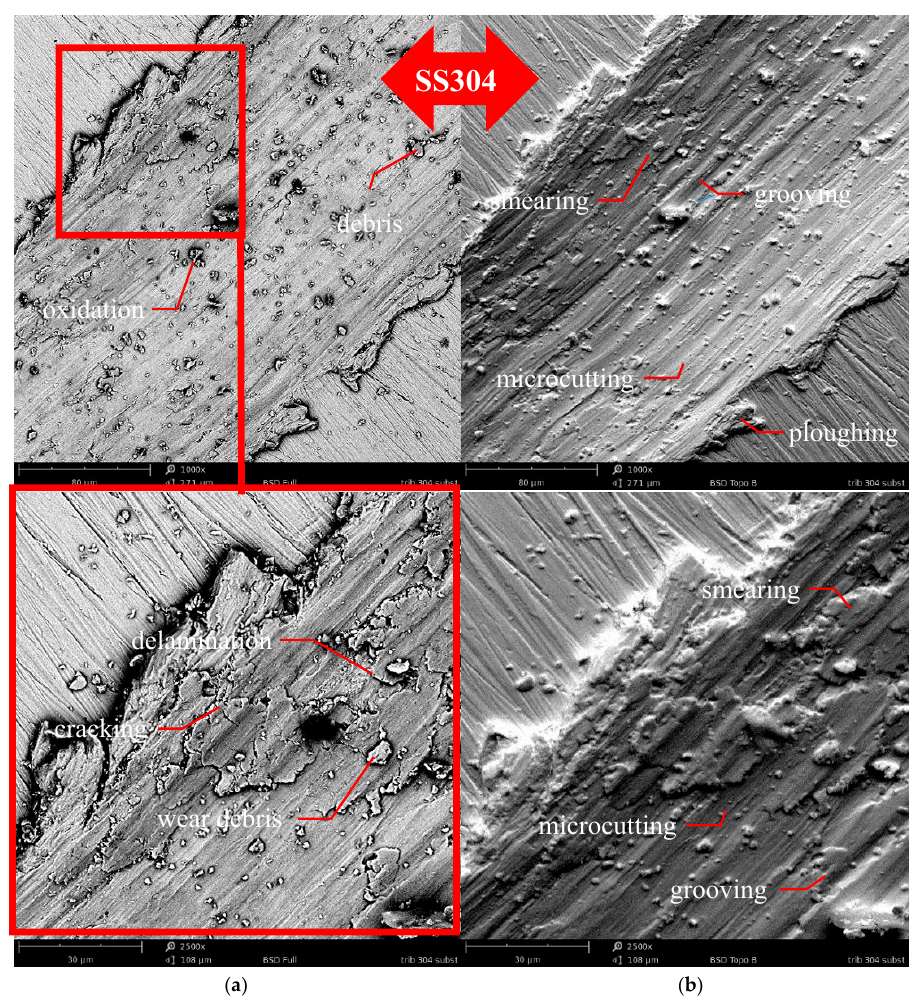
Figure 11. Wear trace on the SS304 sample: ( a ) SEM ‐ BSD and ( b ) SEM ‐ topo, 1000x and 2500x. Coatings 2019 , 9 , 340